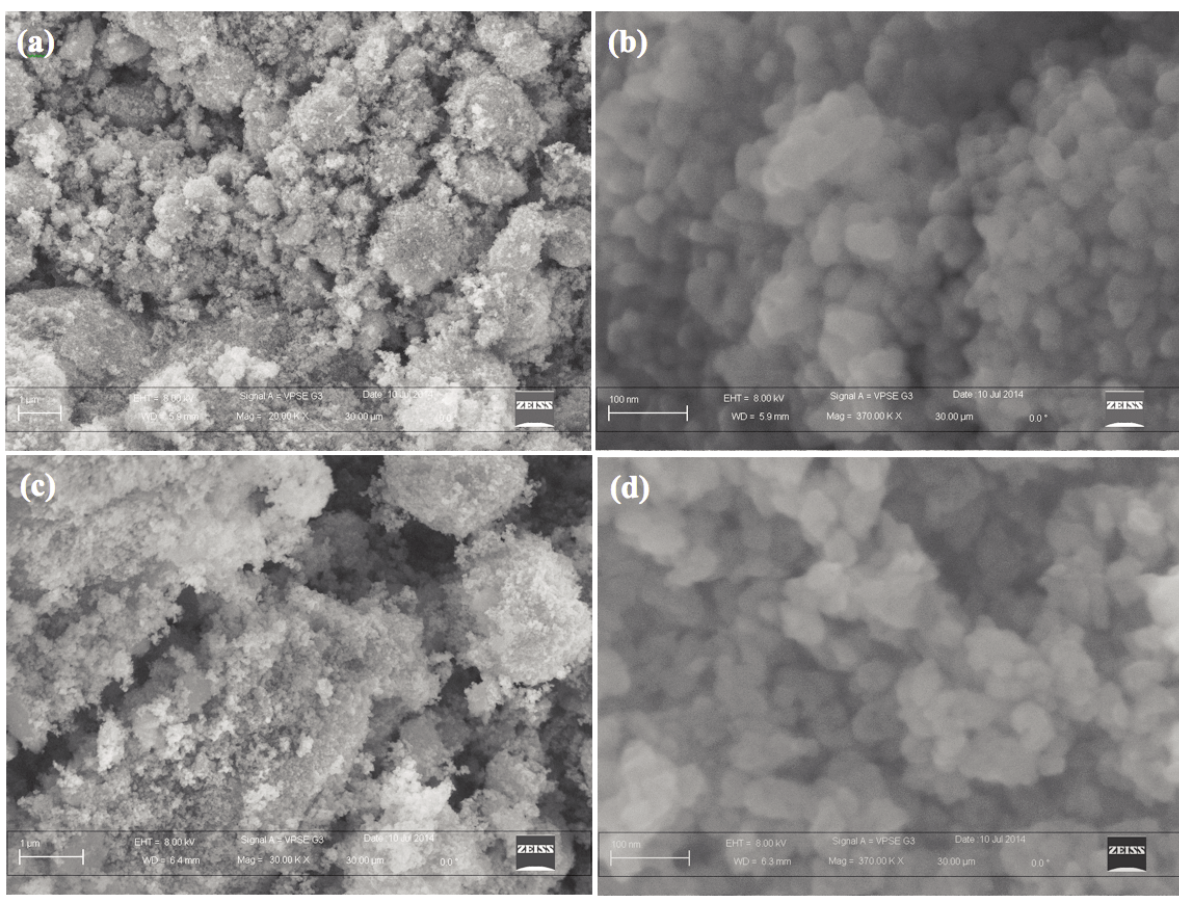
Fig. 5 - FESEM images of (a, b) TSBA-10 and (c, d) TSBA-82 samples.